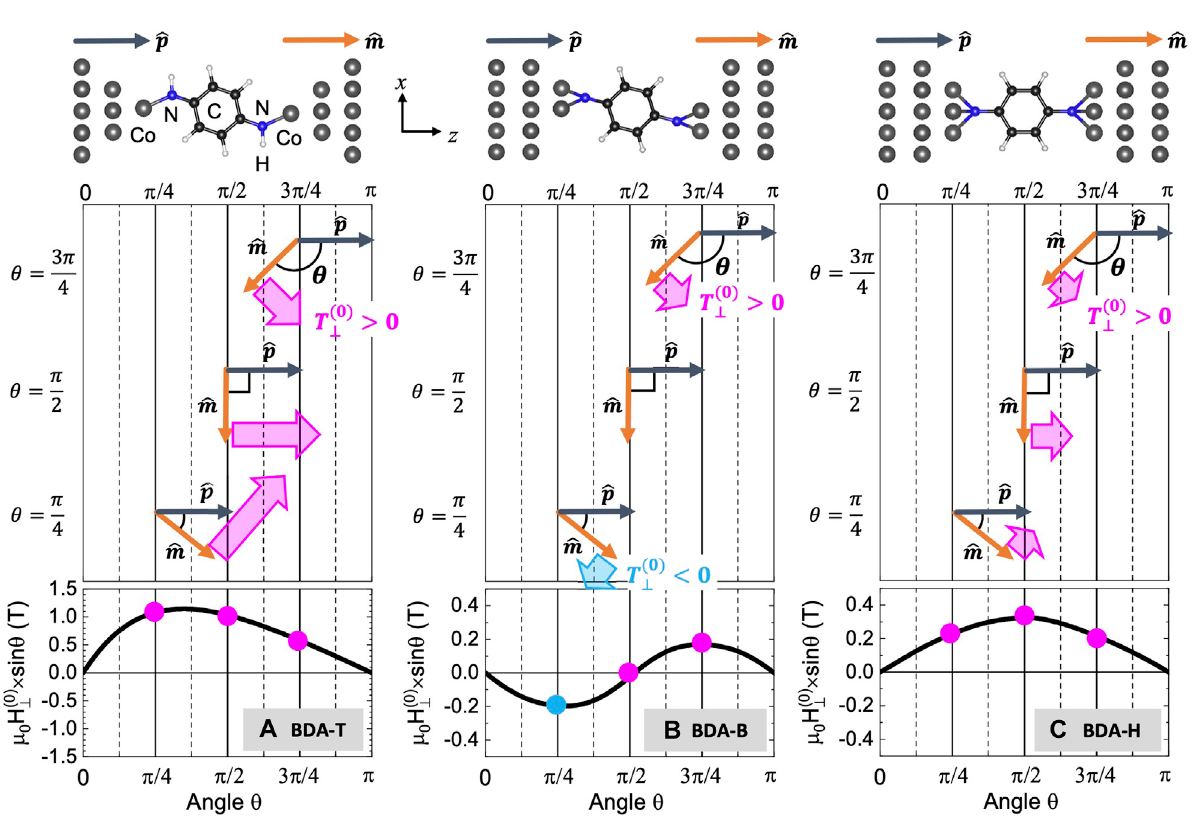
FIGURE 2 [Top] Junction geometries [Middle] the DFT + JUNPY calculated equilibrium FLST, T ( 0 ) ⊥ , for angle θ = π /4, π /2, and 3 π /4, and [Bottom] angular dependence of equilibrium FLST fi eld,